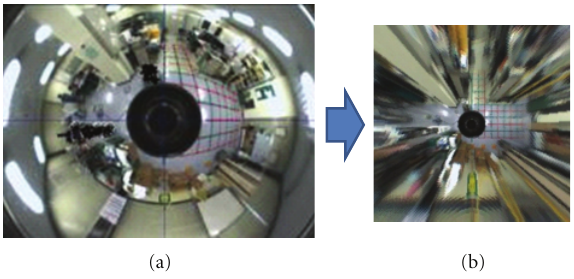
Figure 3: The omnidirectional image of the cross-stripes on the floor (a) and the bird’s eye images (b).